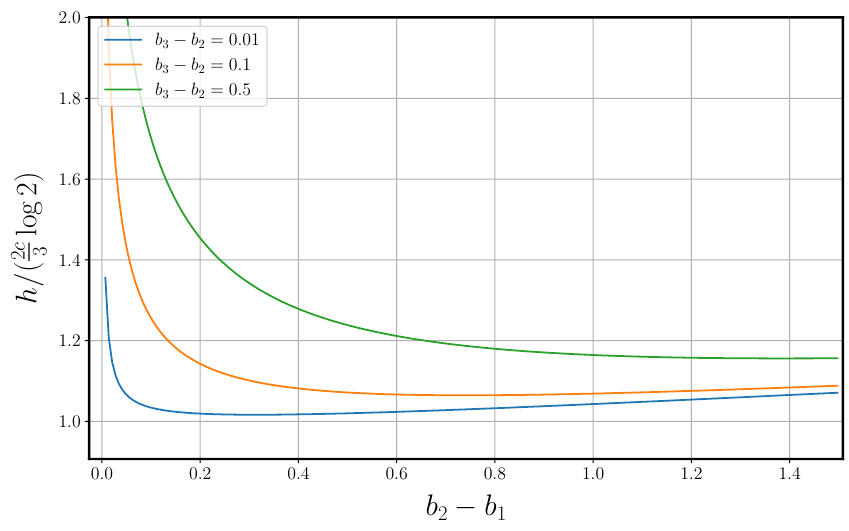
Figure 14 . The Markov gap h (4.15) for phase-D2 of JT model. We set φ r = 100 , c = 12000 and b 1 = 1 . The horizontal axis is b 2 − b 1 , while the vertical axis is h/ ( 2 c to a constant difference b 3 − b 2 . At minima, we have b 3 − b 2 (cid:28) b 2 − b 1 .